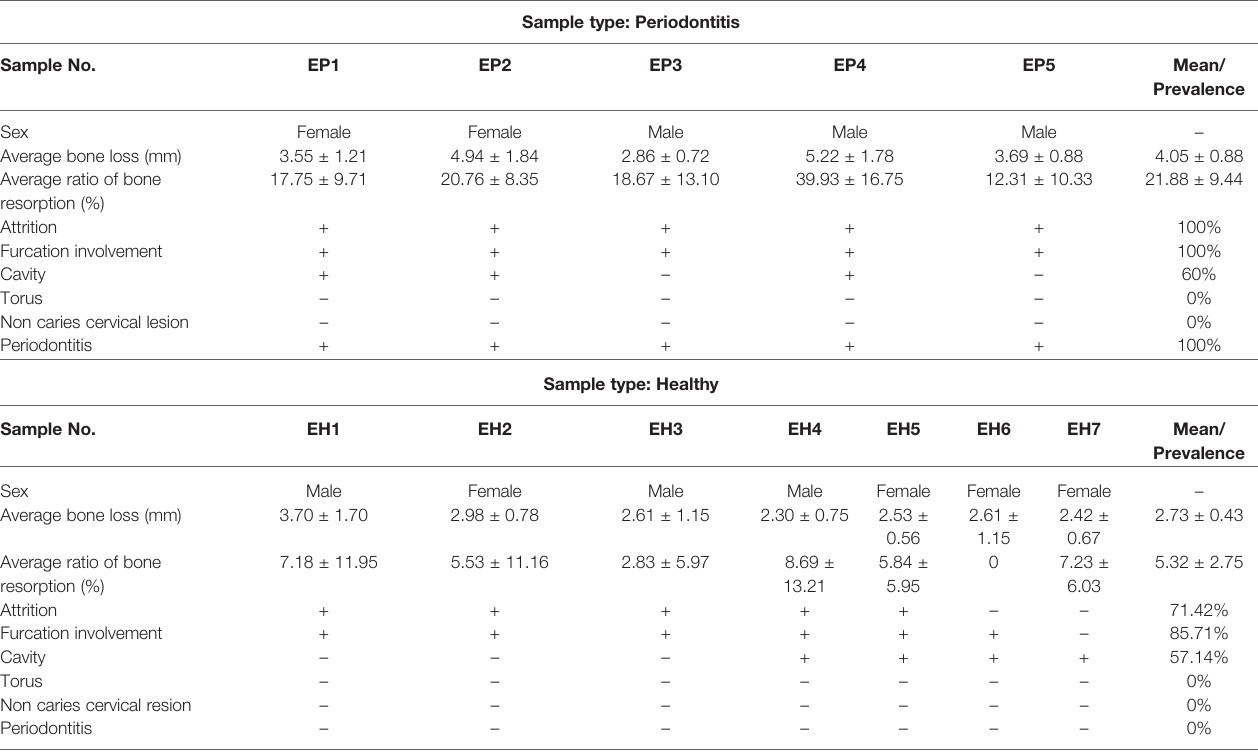
TABLE 1 | Morphological examination of each individual